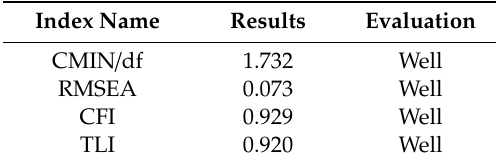
Table 7. Fit index Table 8. Regression weights.